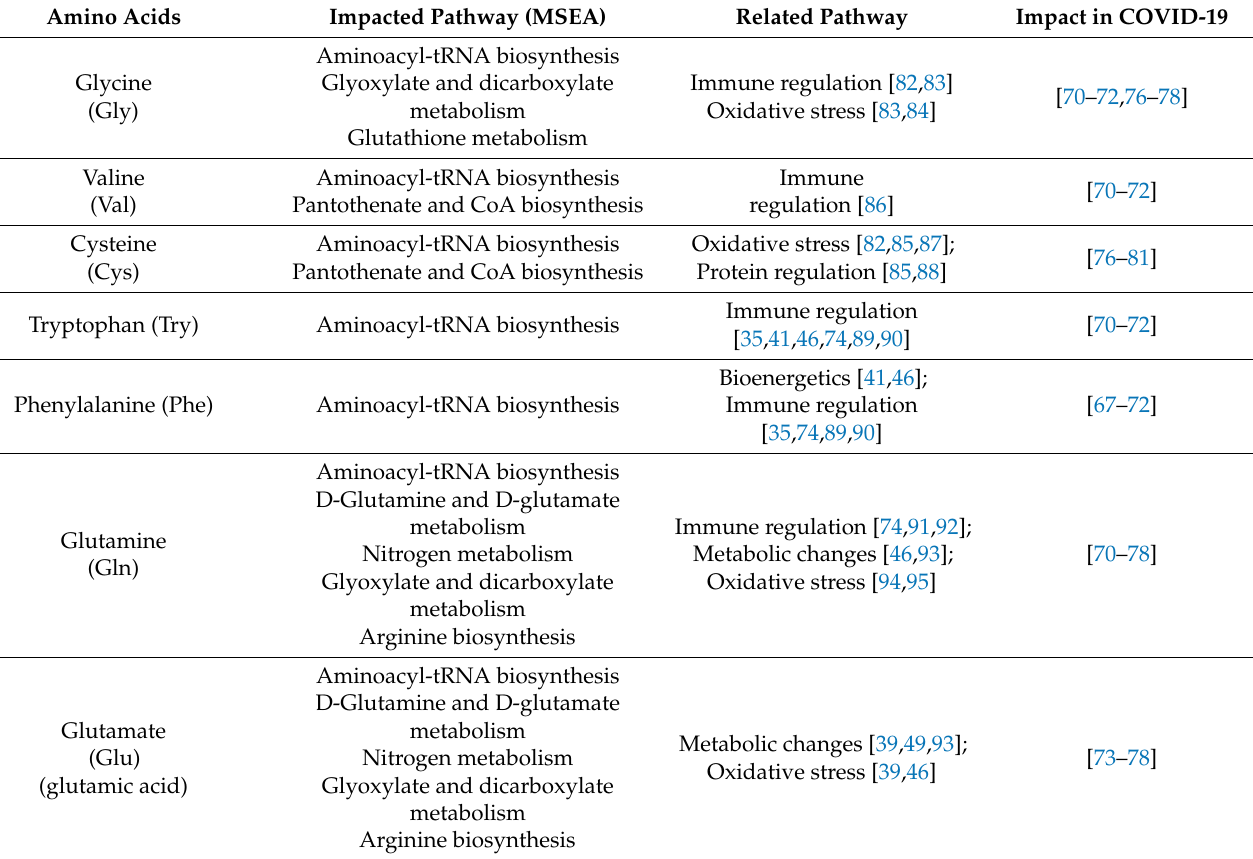
Table 2. Amino acids and pathways significantly altered according to the metabolic set enrichment analysis (MSEA), as well as other related biological processes and their reported biological function when considering COVID-19